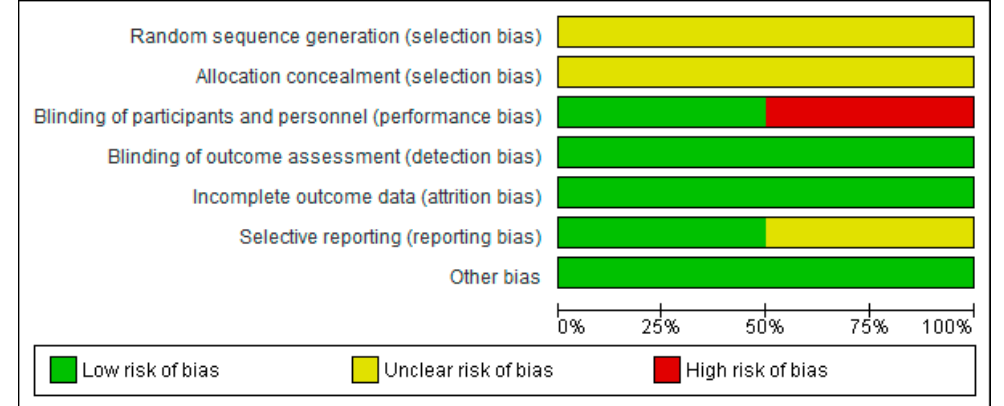
Figure 2. Itemized Judgments for risk of bias based on “The Cochrane Collaboration's tool for assessing risk of bias in randomized trials”. Risk is presented percentages across all included RCTs.